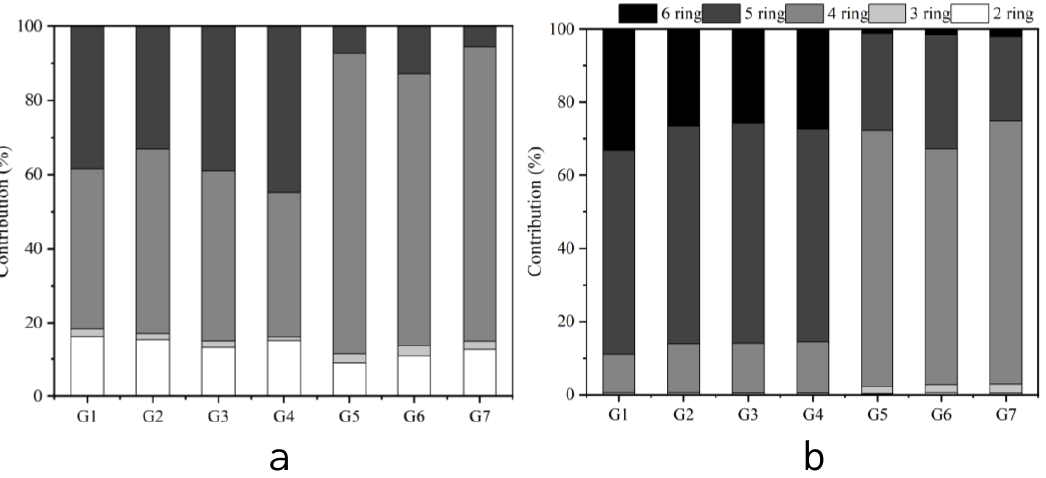
Figure 3. The contribution of PAHs with different ring numbers to the total BaPeq (( a ) refers to the gas phase, ( b ) refers to the particulate phase).